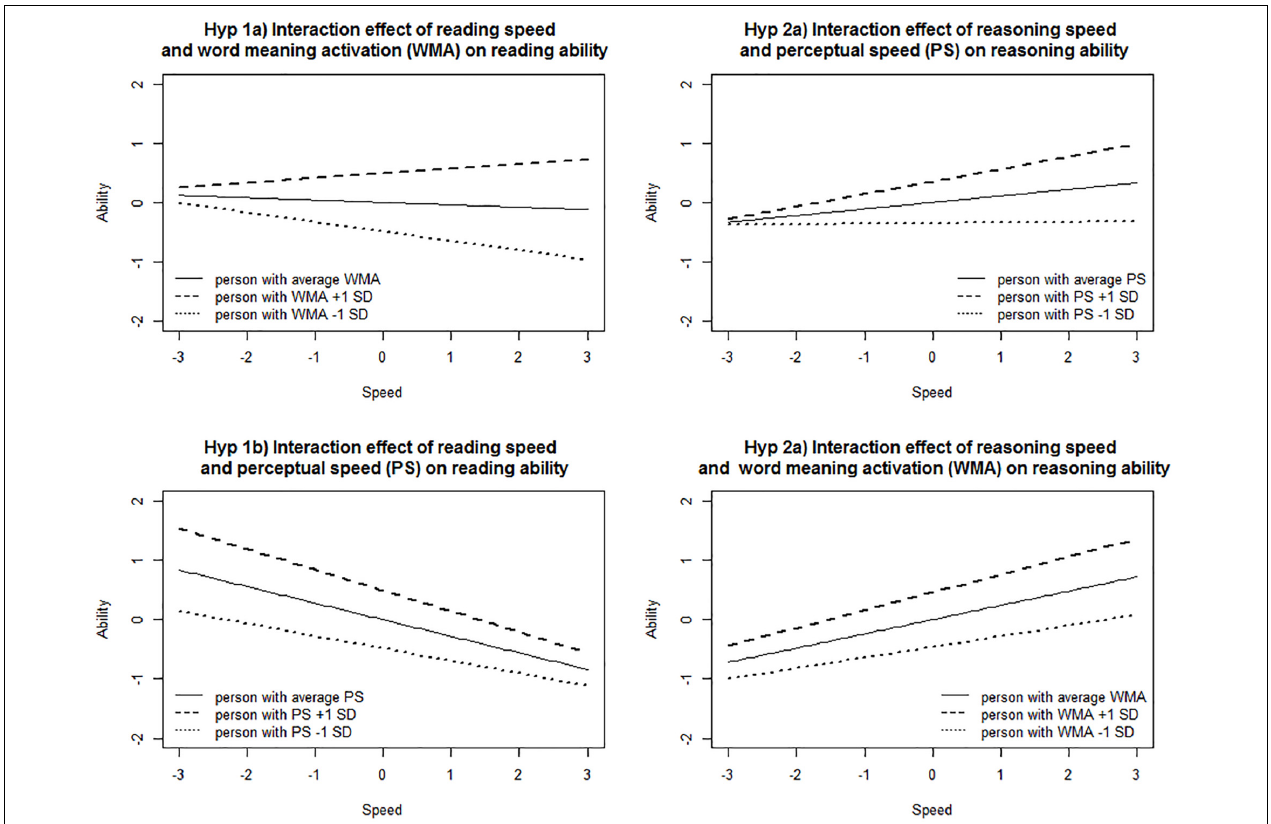
FIGURE 3 | Moderation effects of perceptual speed and word meaning activation for the relation between speed and ability in the reading and reasoning